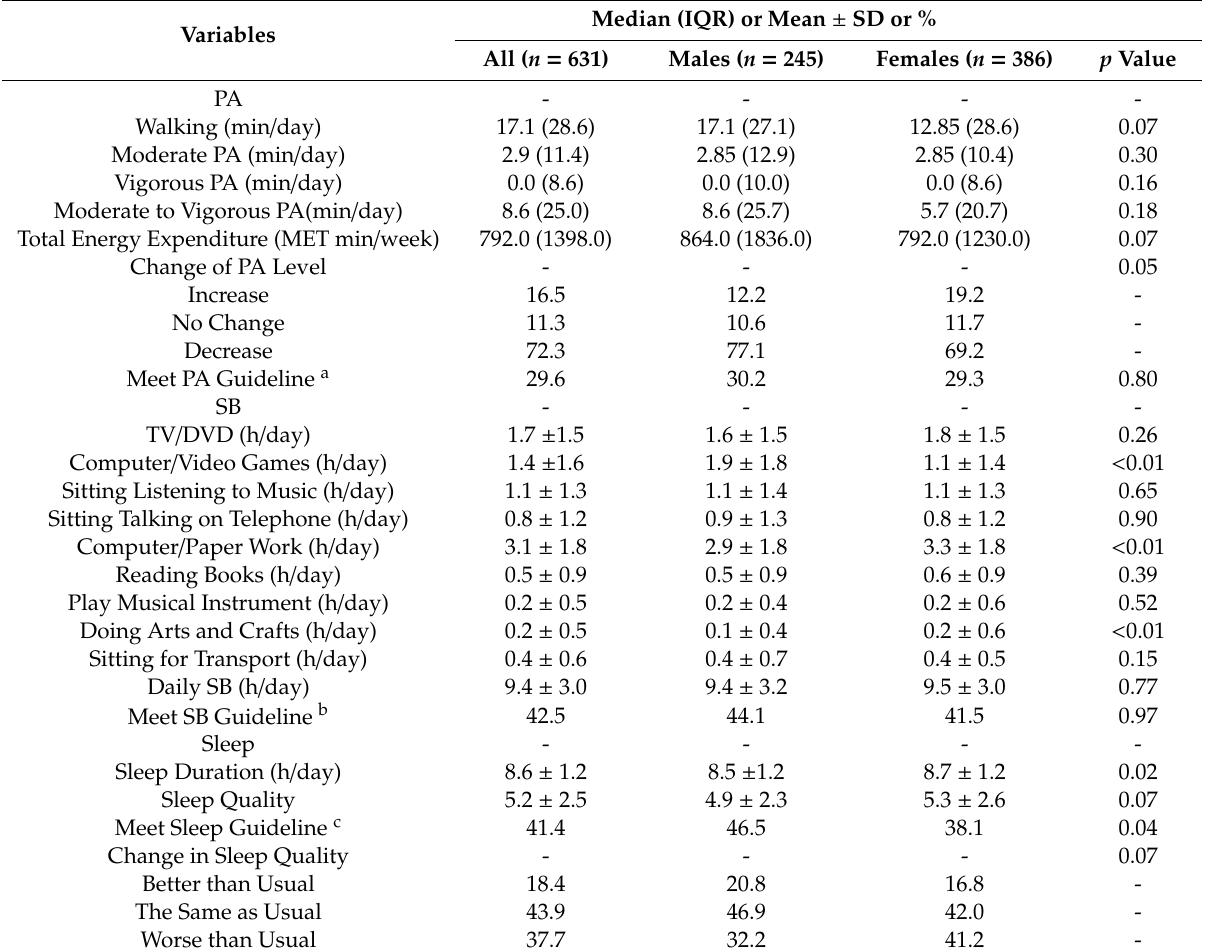
Table 2. Participants’ lifestyle behaviors for cross-sectional study and stratified by sex.